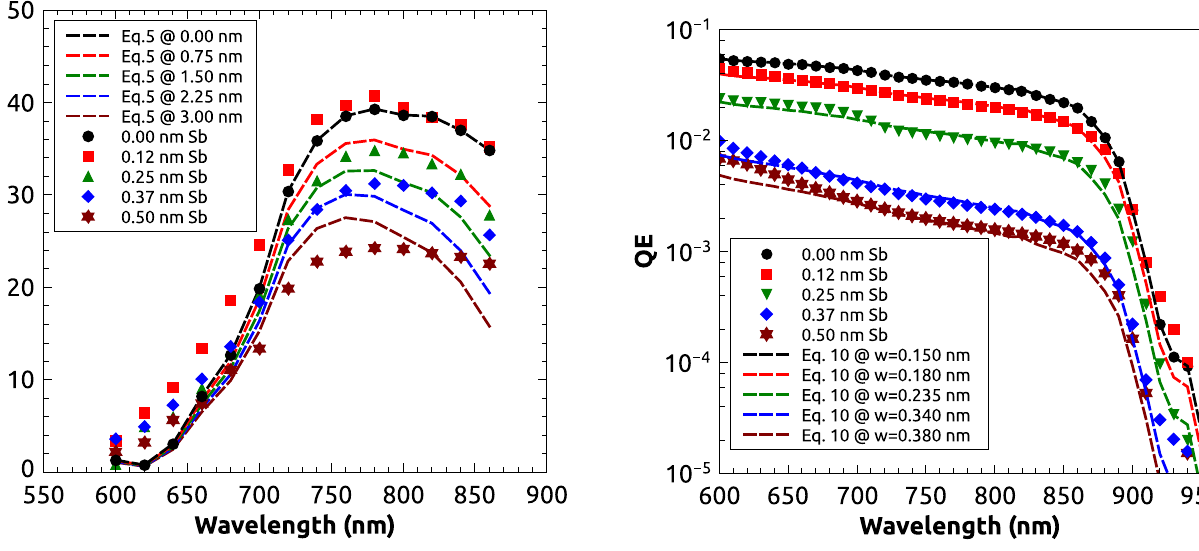
FIG. 9. ESP of the samples activated to NEA with Cs 3 Sb estimated using Eq. (5). The used value of Γ ee is reported in Table II.